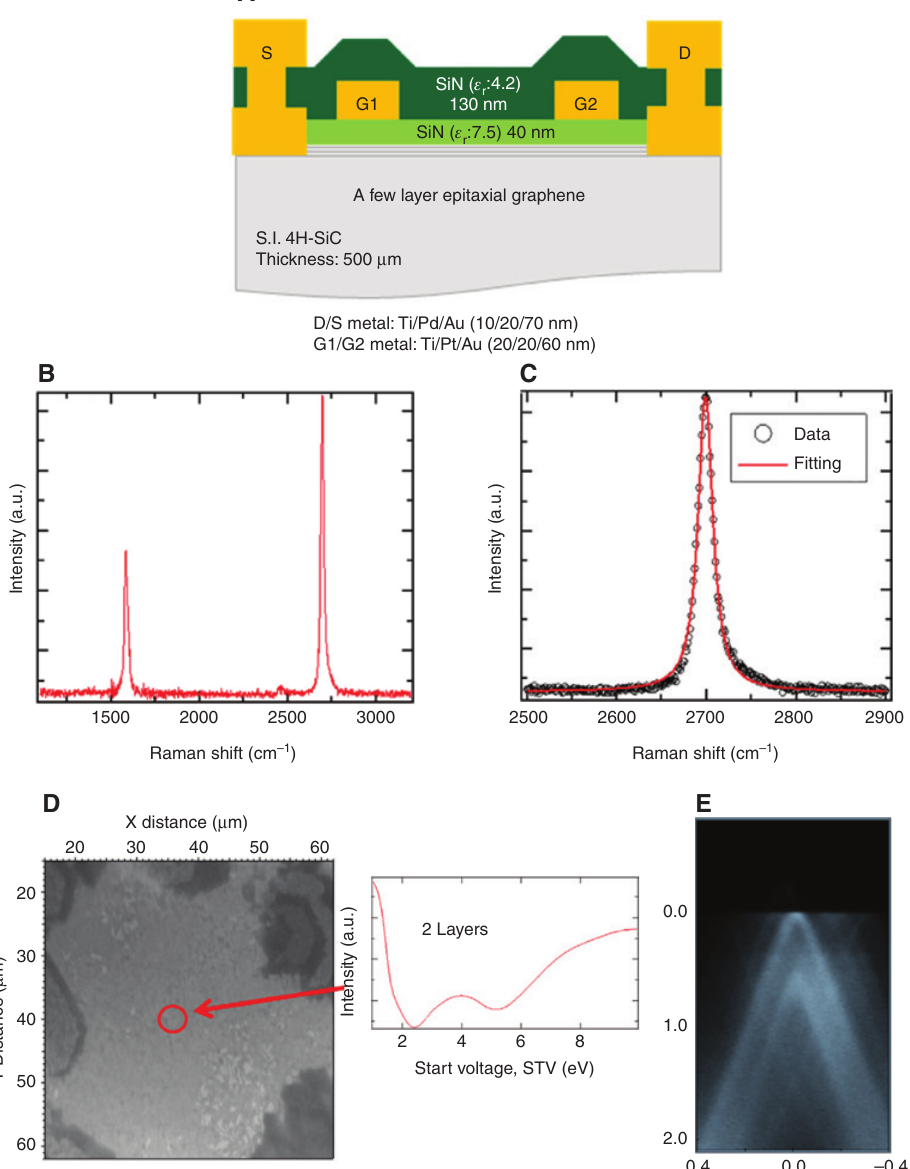
Figure 1: The Raman spectrum (B, C), the LEEM image (D), and the ARPES image (E) confirms D-peak free, high crystal quality, double- layered large ( > 50 μ m) grain, and non-Bernal stacked linear dispersion with not unintentional doping, respectively. (A) Device cross-section, (B) Raman spectroscopy results of the epitaxial graphene on 4H-SiC substarte, (C) Lorentzian curve fitting of G ′ peak confirming the presence of only one peak at 2700 cm −1 with FWHM = 28.52 cm −1 , (D) LEEM image and electron reflectance spectrum of epitaxial grapheme © Jpn Soc Appl Phys [52], and (E) ARPES image © Jpn Soc Appl Phys